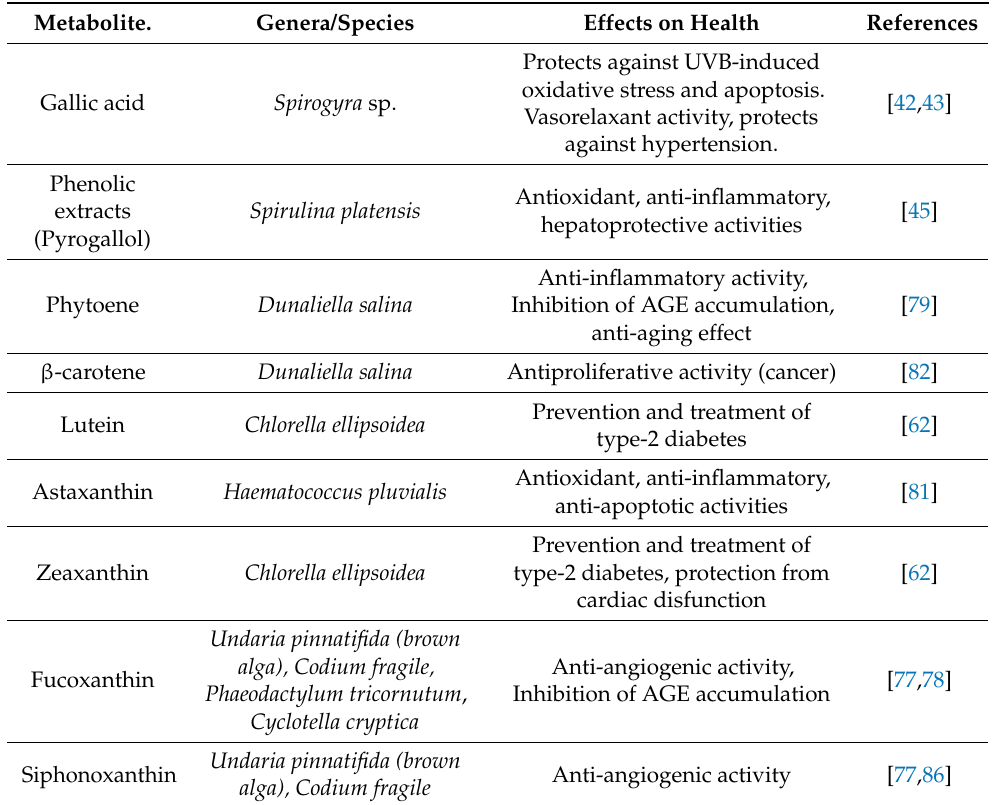
Table 1. Examples of metabolites extracted from algae and their health-promoting effects.